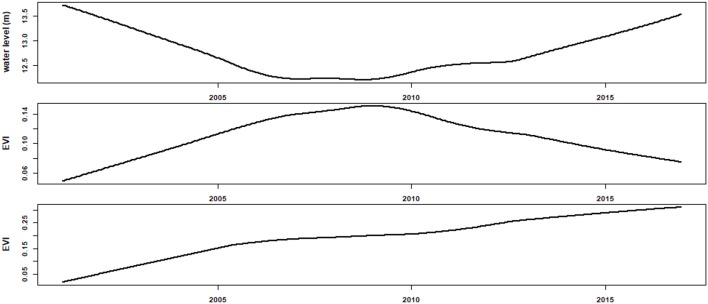
The trend of water level at Xingzi (upper), examples of EVI trend of the wet meadows in controlled (middle), and connected sub-lakes (lower), showing the opposite but synchronous trends between water level and EVI for controlled sub-lakes.